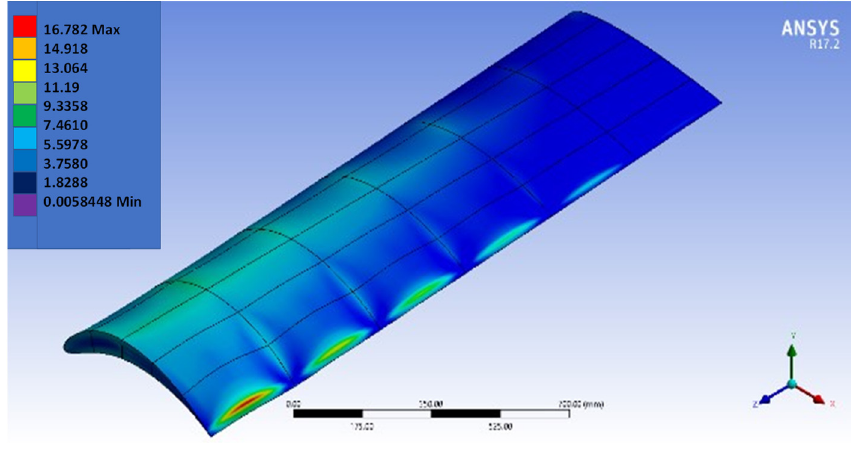
Figure 2. NACA2410-2410 wing and its dimensions.